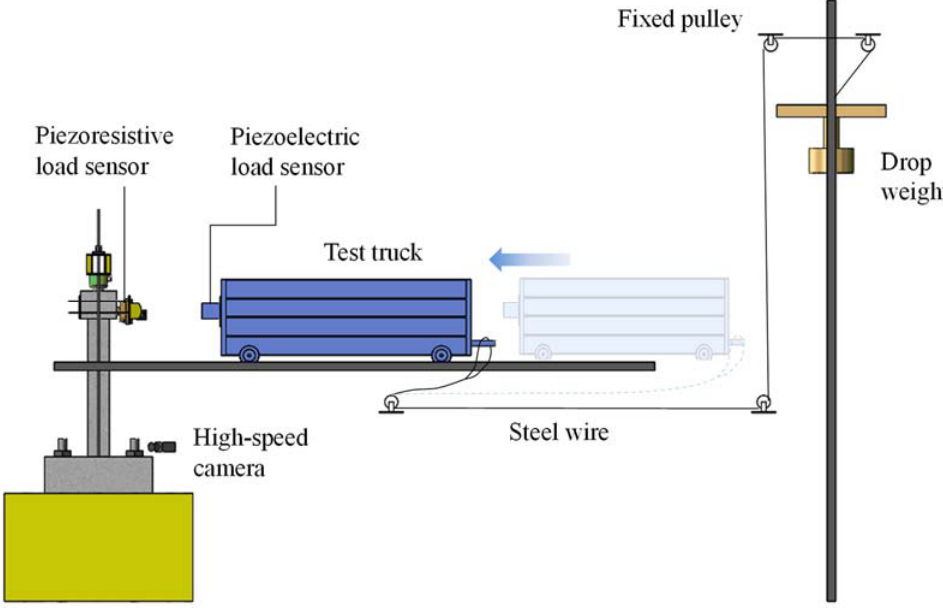
Figure 3. Impact test set-up. Table 2. Details of the specimens and impact test results.